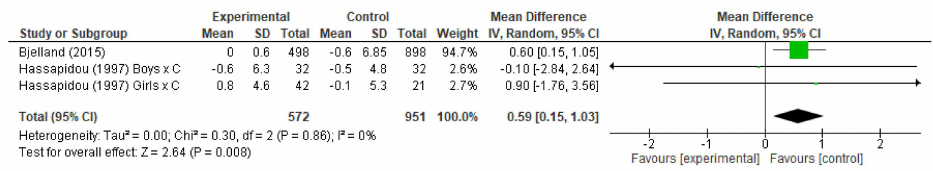
Figure 5. Forest plot of the vegetable consumption changes